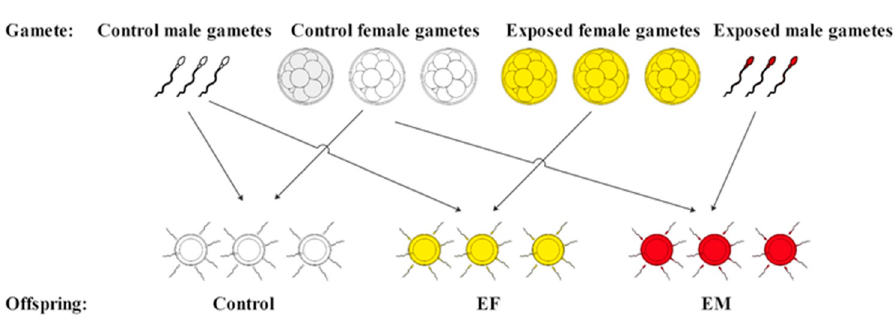
Figure 1. The schematic diagram of the gametes combinatorial design of sea urchins at each oil- loading treatment: control (control female gametes fertilized by control male gametes), EF (exposed female gametes fertilized by control male gametes) and EM (control female gametes fertilized by exposed male gametes).